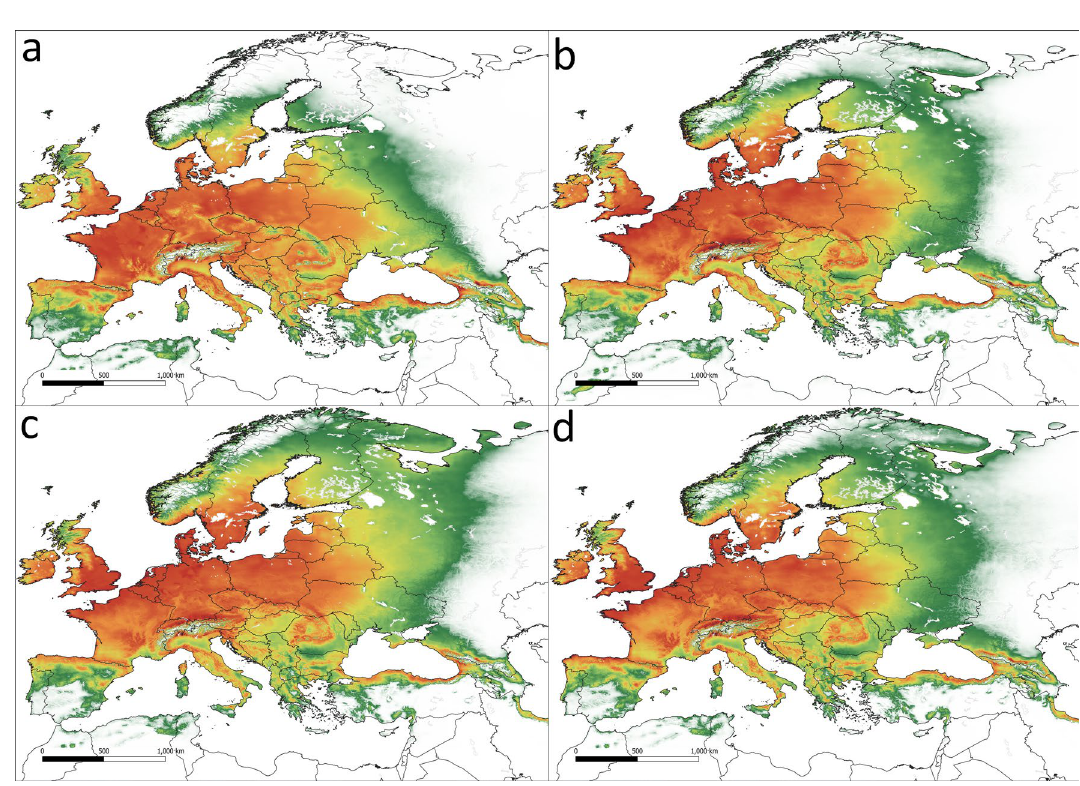
Figure 7. The potential range of Viscum album subsp. album . ( a ) current conditions, ( b ) scenario SSP 1.26, ( c ) scenario SSP 3.7, ( d ) scenario SSP